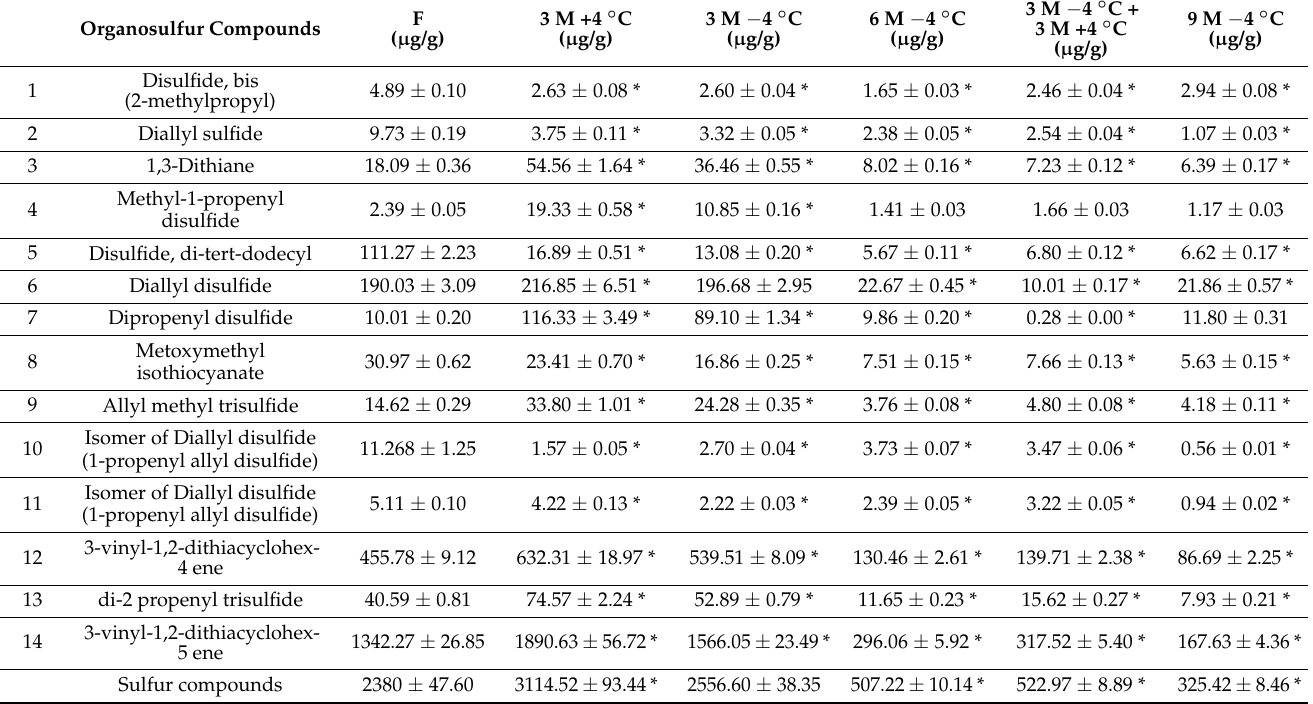
Table 1. Organosulfur compound compositions in fresh Voghiera garlic hydro-alcoholic extract and after different storage periods ( µ g/g of fresh matter, n = 3 ± SD). * p < 0.05 vs. fresh